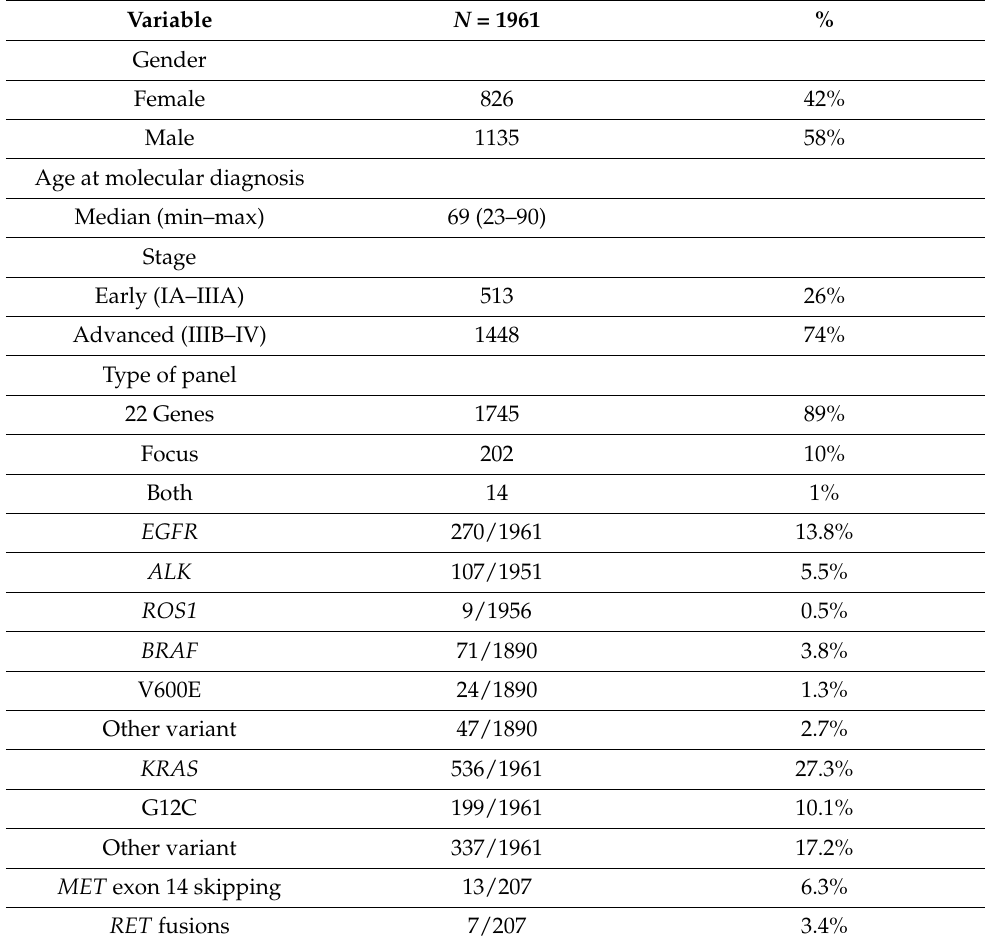
Table 1. Patient